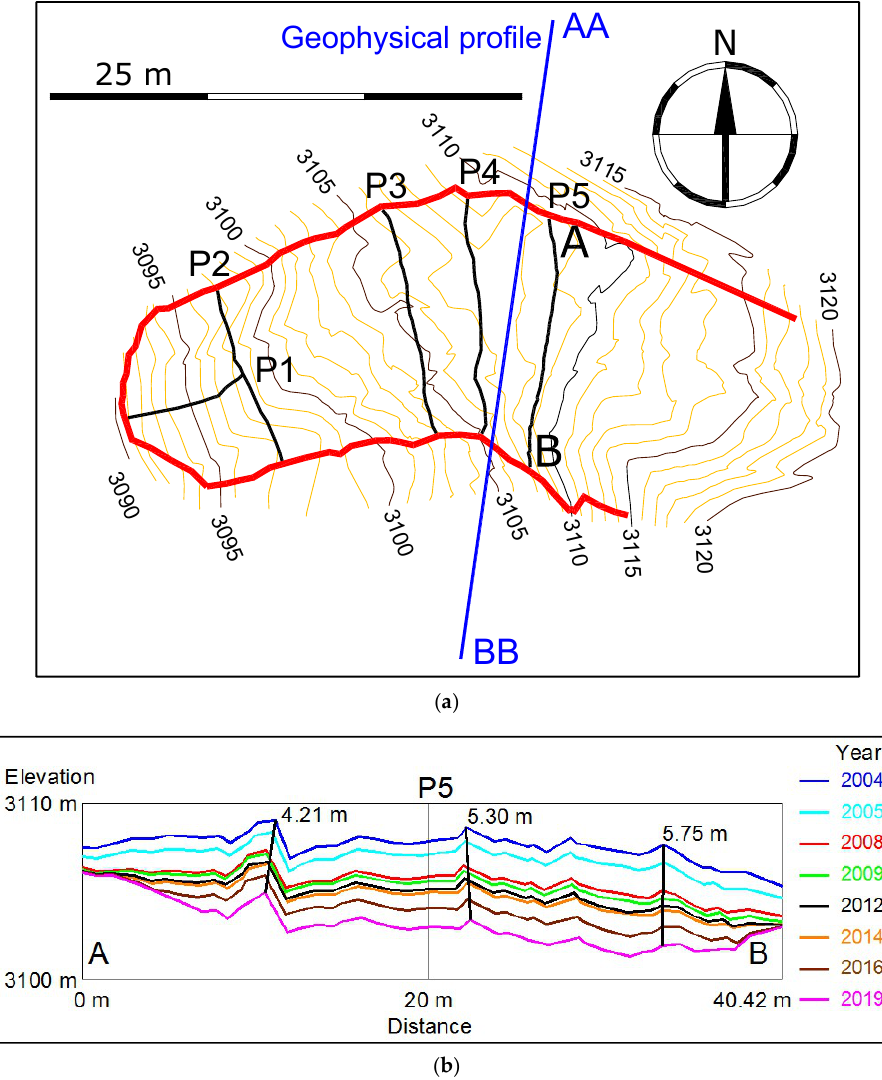
Figure 5. ( a ) Positions of the topographic profiles and the geophysical profile on the automatic cartography (Restitutor) of 2008. ( b ) Evolution of profile P5 between 2004 and 2019. The analysis of the profiles reveals that the same volume loss does not occur in the centre of the glacier as in the areas close to the outline (Figure 5b). The topographic profiles in the frontal part of the rock glacier (profiles: P1 and P2) indicate that from 2004 to 2019 (a 15 year period) the mean loss of the underlying frozen mass was over 5.3 m (Figure 5b). Some points in the central and back areas of the rock glacier underwent greater subsidence (sinking by 7.8 m). The general evolution of the profiles indicates that the mean loss of elevation of the rock glacier was approximately 5.27 m which, extrapolated to the volume of permafrost loss in 2001–2019, was 20,105 m 3 .